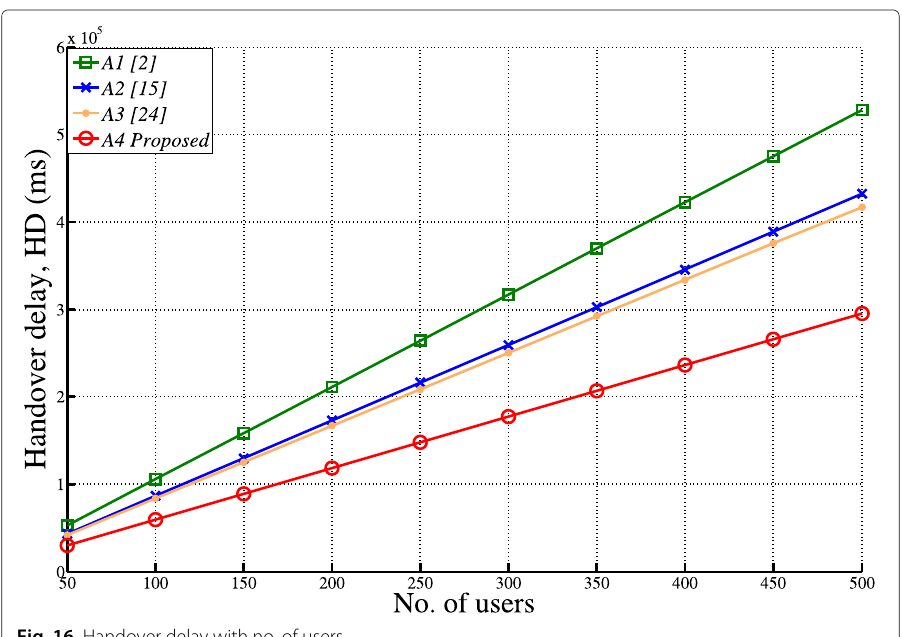
Fig. 16 Handover delay with no. of